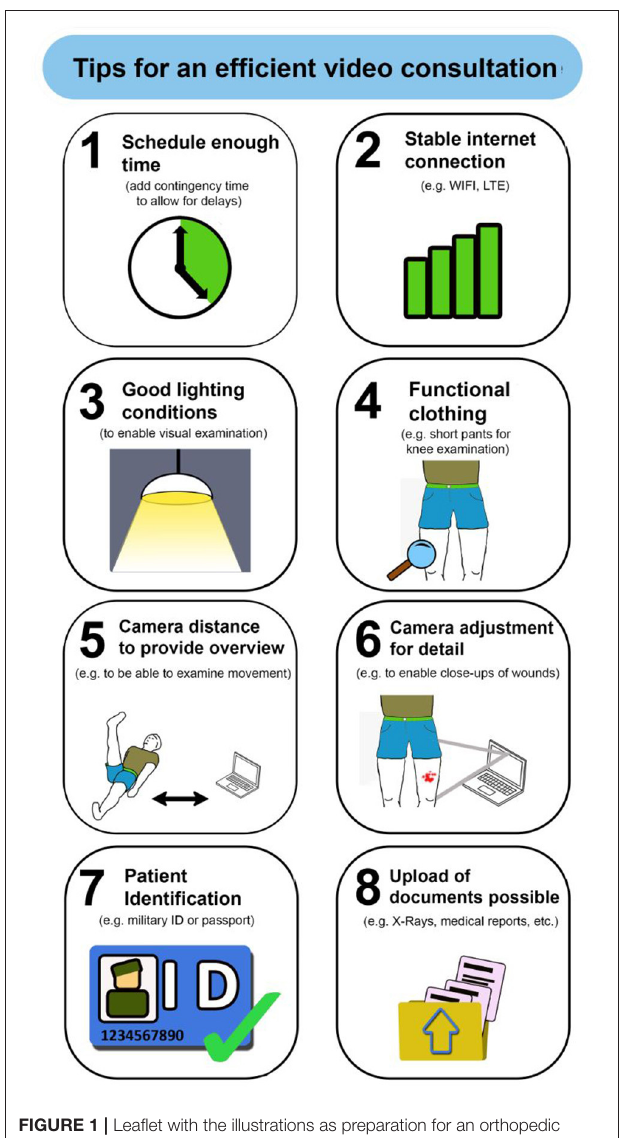
FIGURE 1 | Leaflet with the illustrations as preparation for an orthopedic telemedical consultation.